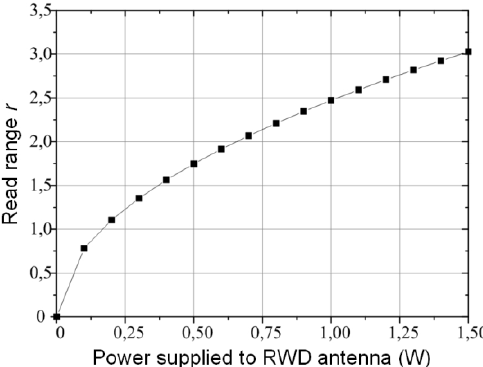
Figure 15. Tests of RFID interface in flow sensor — read range r .